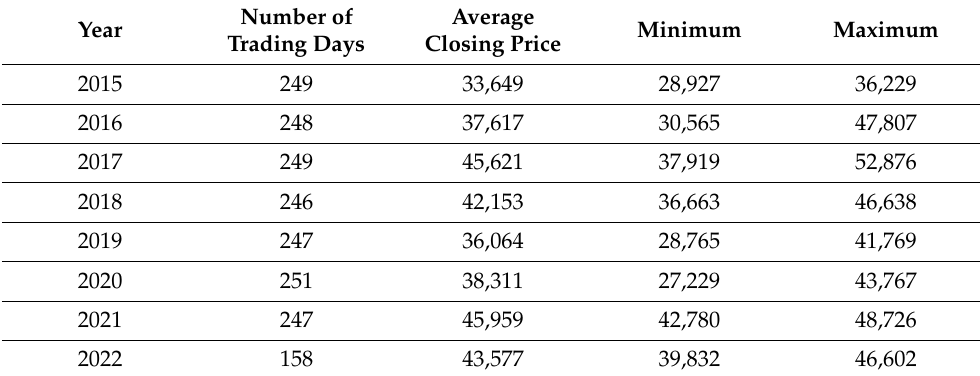
Table 2. Descriptive statistics of yearly KSE-100 index closing